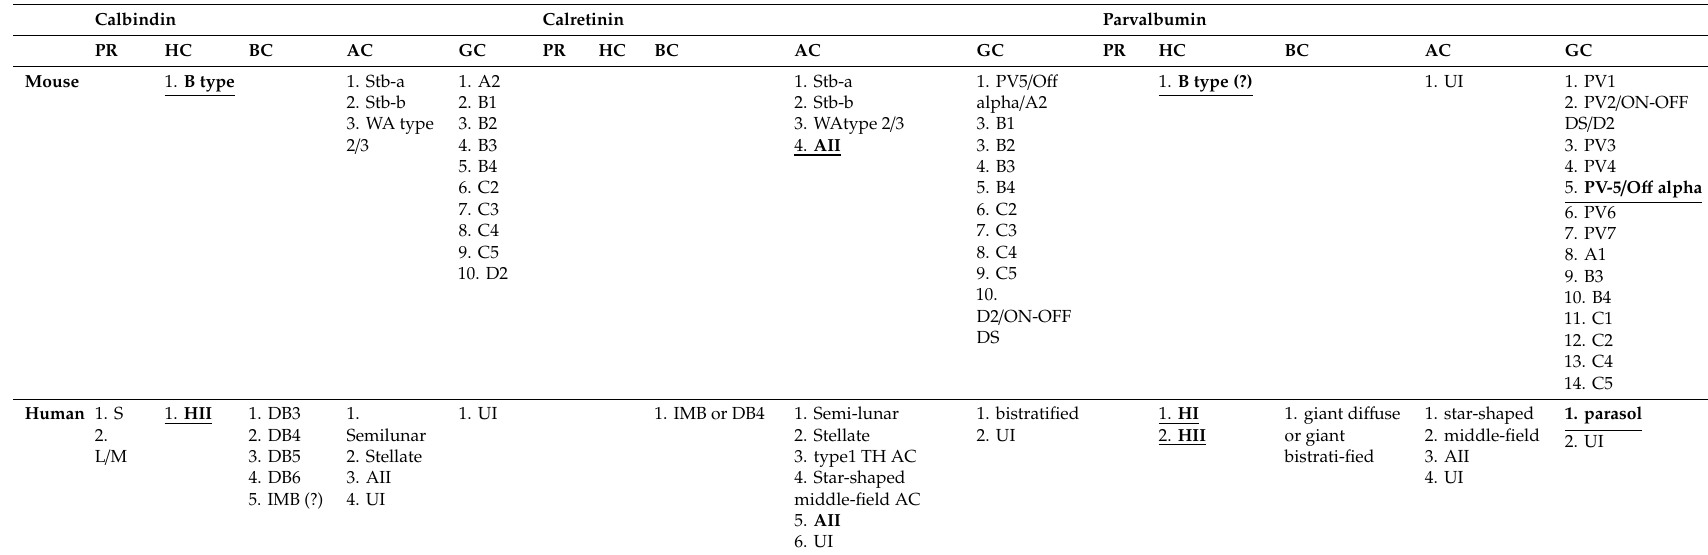
Table 1. Cell types expressing major EF-hand CaBPs (CaB, CaR, PV) in the mouse and human